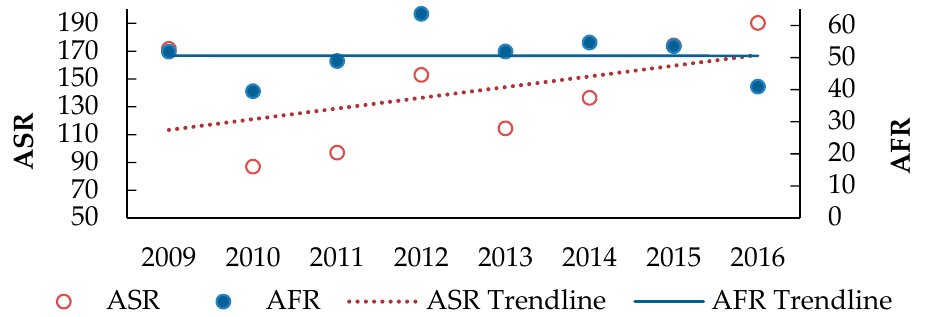
Figure 14. ASR and AFR Rates of the industrial sectors during 2009–2016. Where ASR = Number of reported human-days lost × 1,000,000/number of human-hours worked, AFR = Number of workplace accidents reported per number of human-hours worked × 1,000,000.